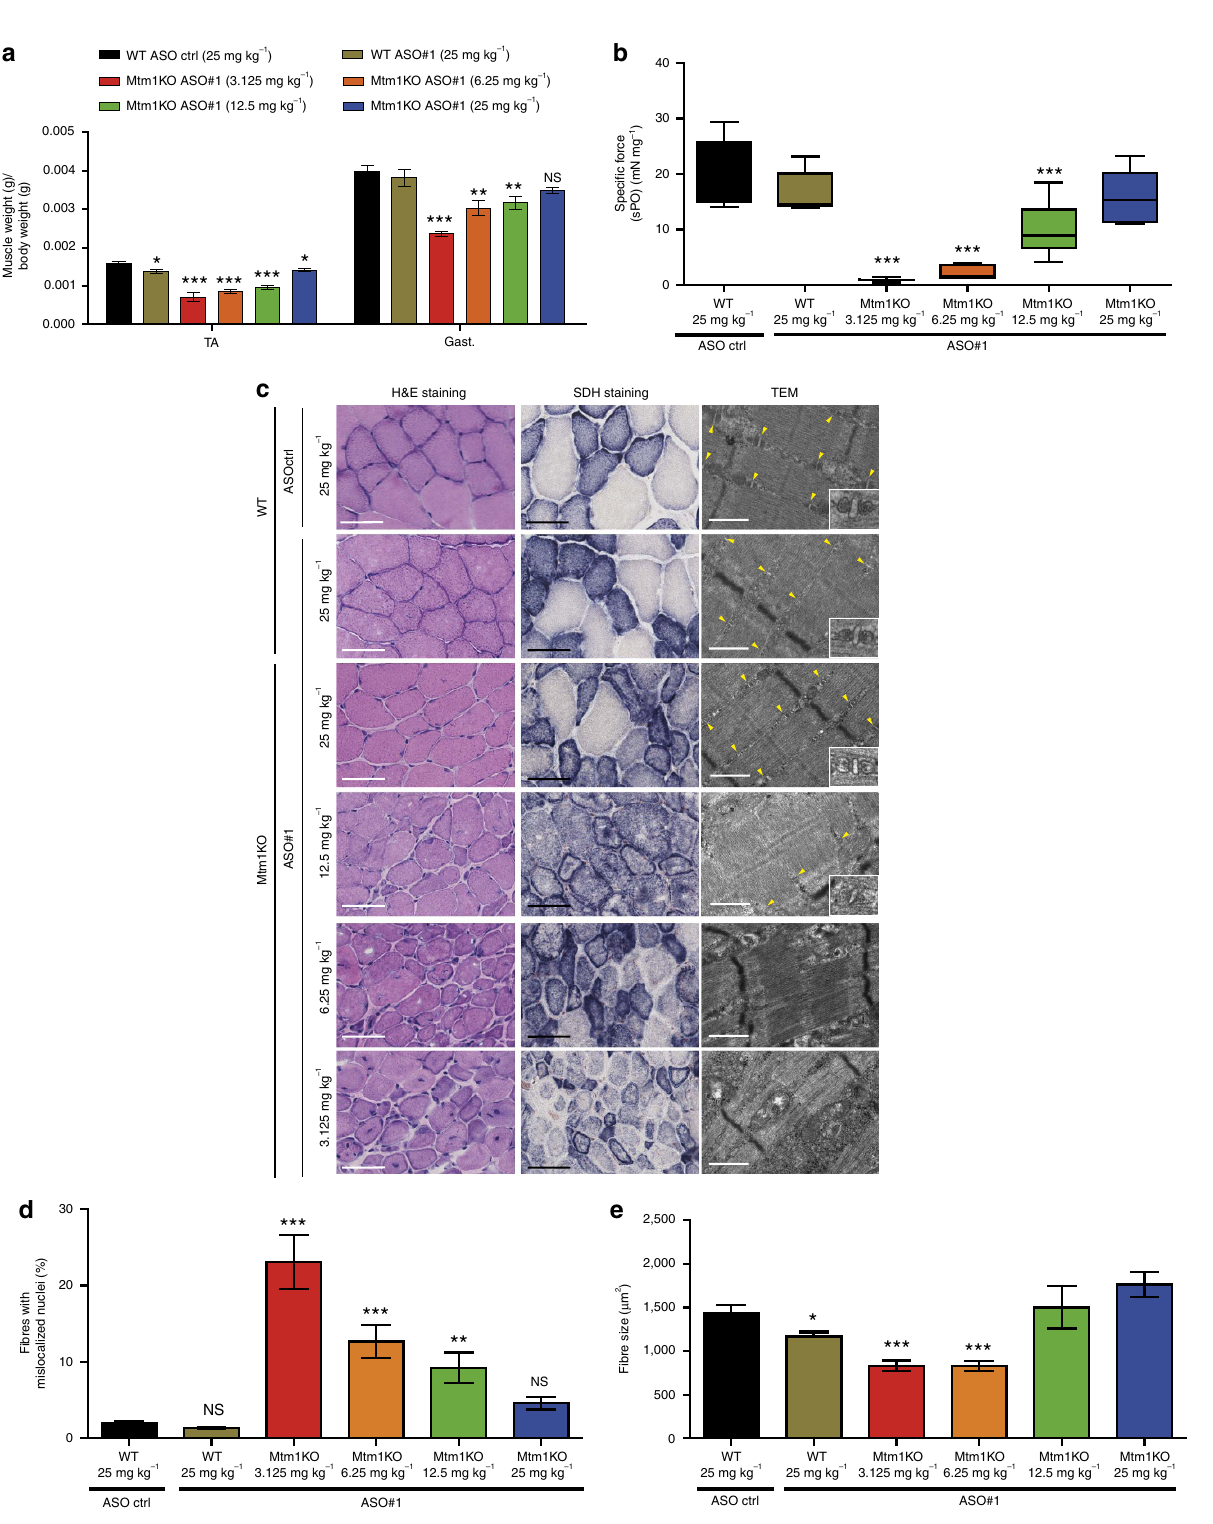
Figure 5 | Physiological effects of ASO- Dnm2 systemic injections at 12 weeks of age. ( a ) TA and gast. muscle weights from these mice were measured and the ratio relative to the body weight was represented. ( b ) The TA in situ muscle force was measured after sciatic nerve stimulation. The specific muscle force was calculated by dividing the absolute force by the TA weight. ( c ) TA muscle transversal sections stained with H&E (left panel) and SDH (middle panel) at 12 weeks (10 weeks of treatment). Sarcomere and triads (yellow arrows) ultrastructure assessed by TEM (right panel). Scale bars for H&E and SDH is 50 m m and 500nm for TEM pictures. ( d ) The percentage of fibres with mislocalized nuclei was counted on 1,000 fibres per group. ( e ) TA muscle fibre area was calculated on 300–600 fibres per sample. For all tests cited above, n ¼ 5–7 mice per group except for Mtm1KO treated with 3.125mgkg (cid:2) 1 where n ¼ 3. Data represent means ± s.e.m. NS, no statistical significance, * P o 0.05, ** P o 0.01, *** P o 0.001 for mice treated with ASO#1 versus WT treated with ASO control (ctrl) (ANOVA test followed by post hoc